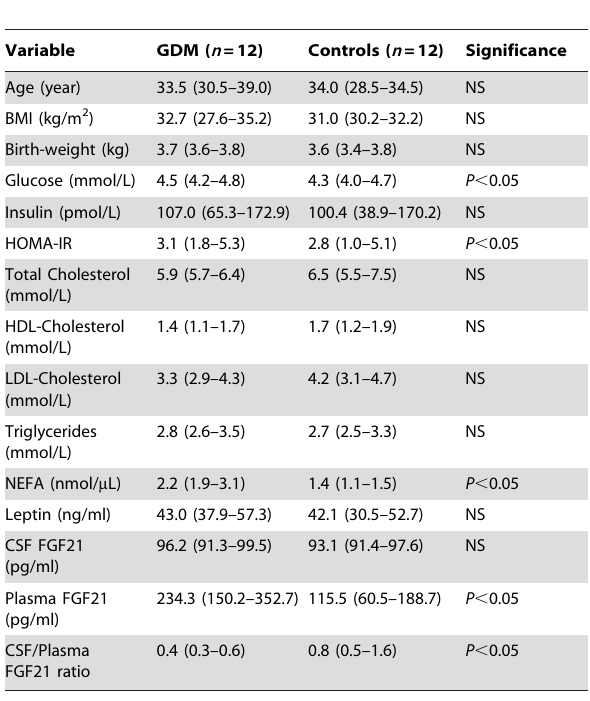
Table 1. Clinical, hormonal and metabolic features of women with GDM and controls.